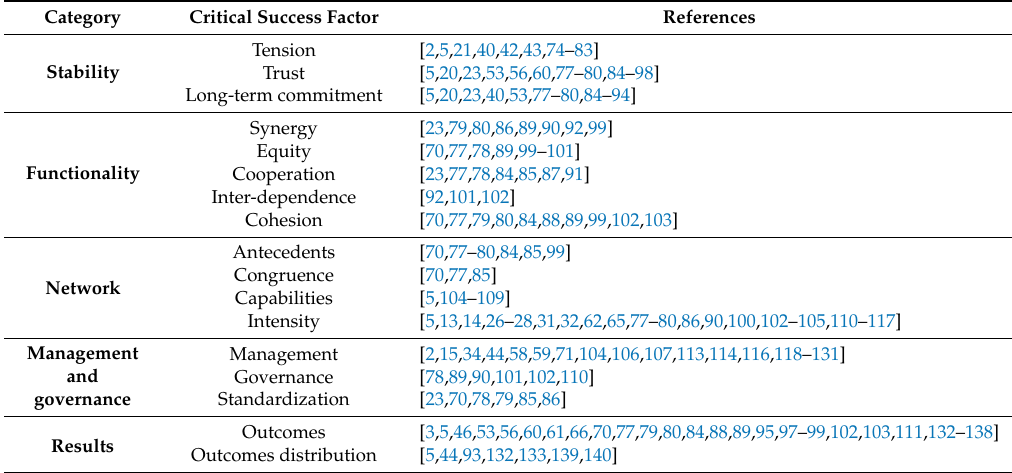
Table 1. Conceptual